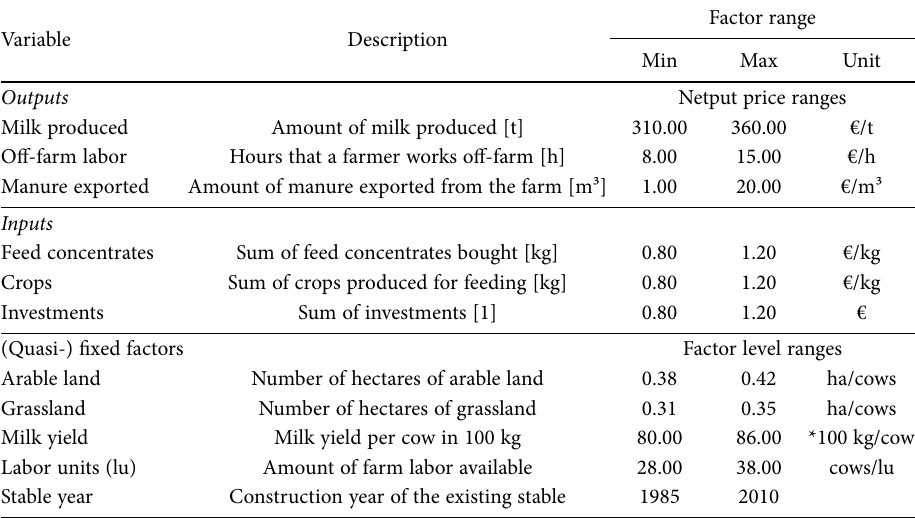
Table 1. Variables included in the meta-model for the farm branch